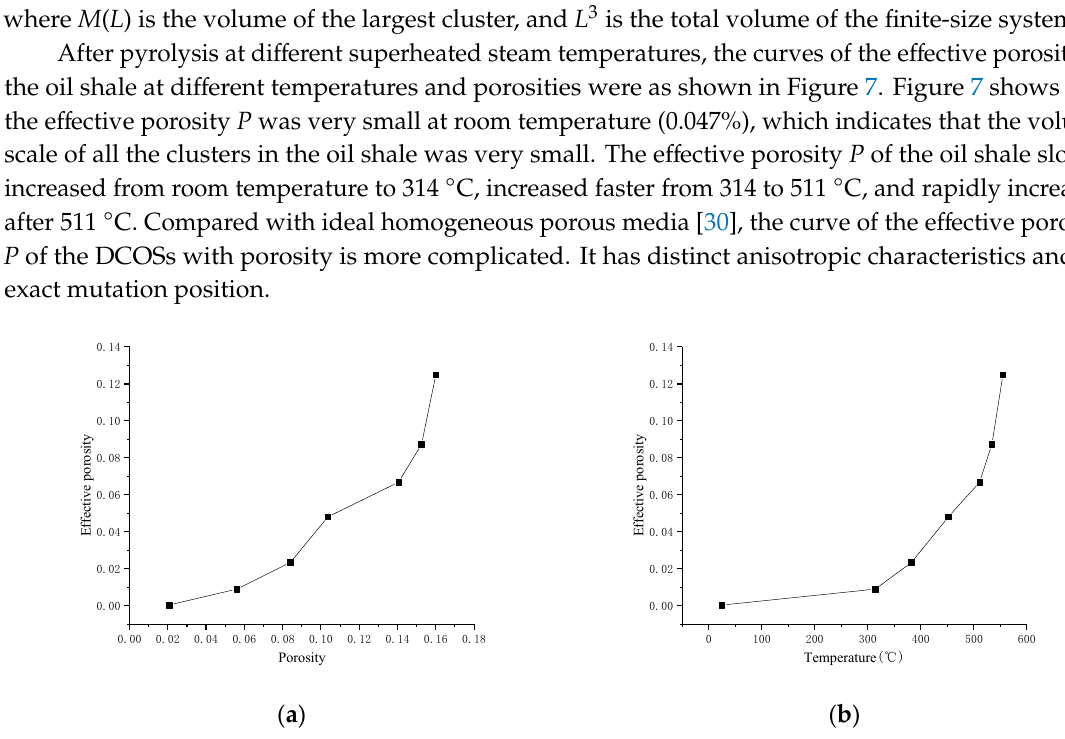
Figure 7. Curves of effective porosity of oil shale at: ( a ) different porosities; ( b ) different temperatures.